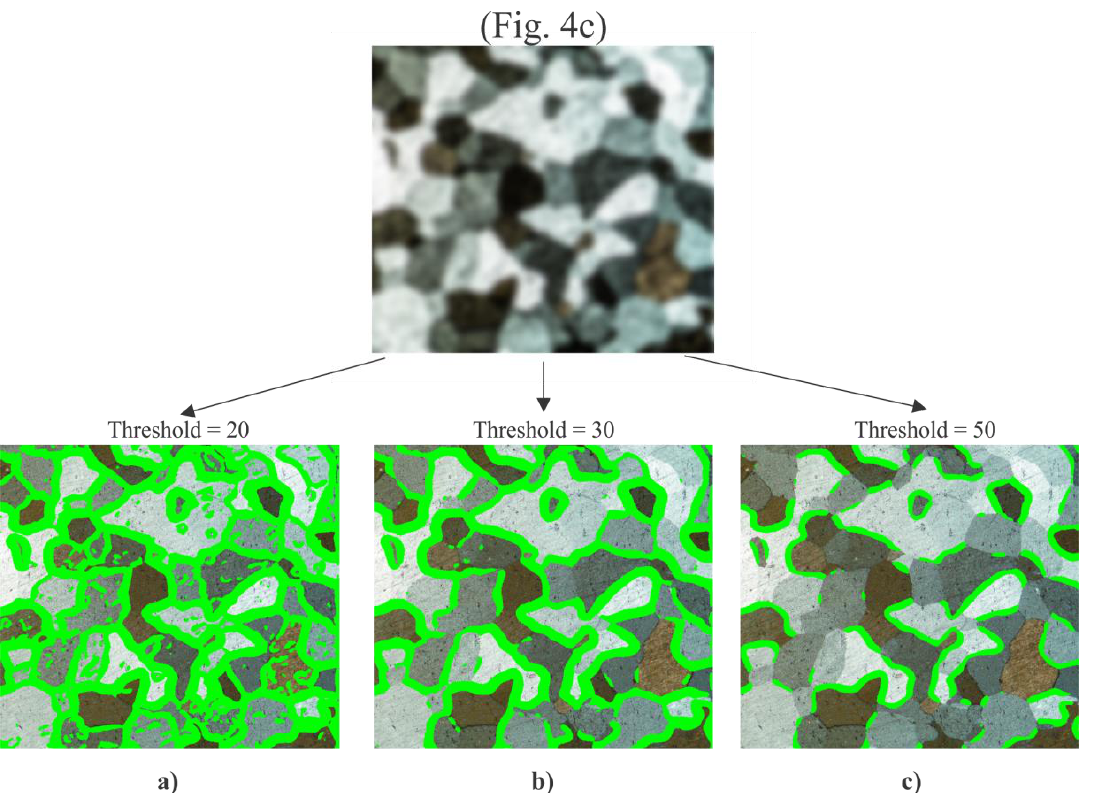
Figure 5. Sobel gradient filter different threshold values 𝑡ℎ𝑟𝑒𝑠ℎ𝑜𝑙𝑑1 = 20 ( a ), 𝑡ℎ𝑟𝑒𝑠ℎ𝑜𝑙𝑑2 = 30 ( b ) in 𝑡ℎ𝑟𝑒𝑠ℎ𝑜𝑙𝑑3 = 50 ( c ).